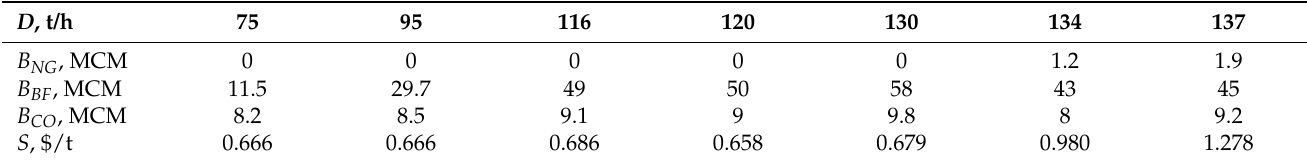
Table 7. Feasibility Model of Boiler No. 1.